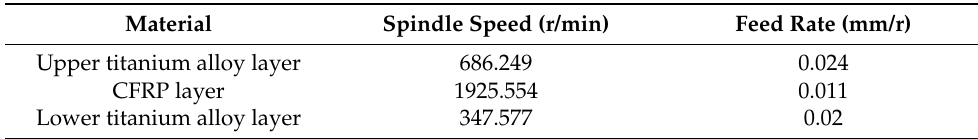
Table 3. Optimized results of genetic